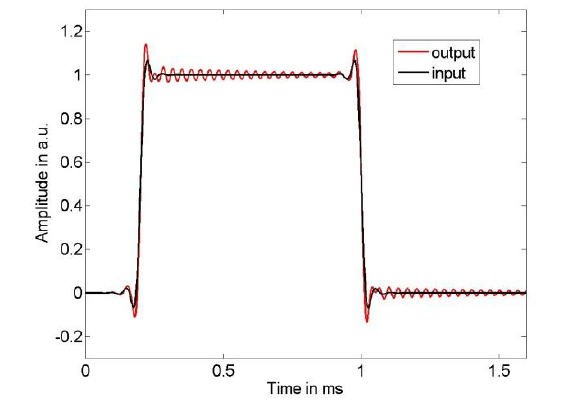
Figure 2. Narrow-banded sensor input signal and resulting sensor output signal.